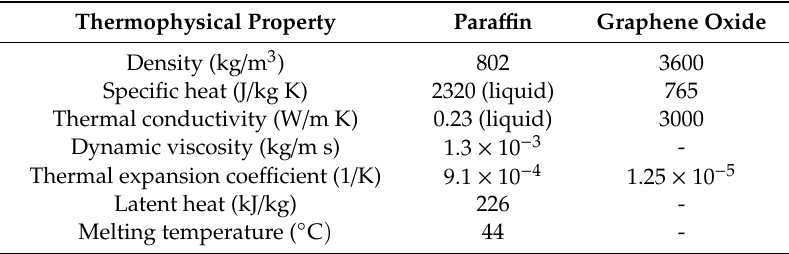
Table 2. Thermal properties of PCM and graphene